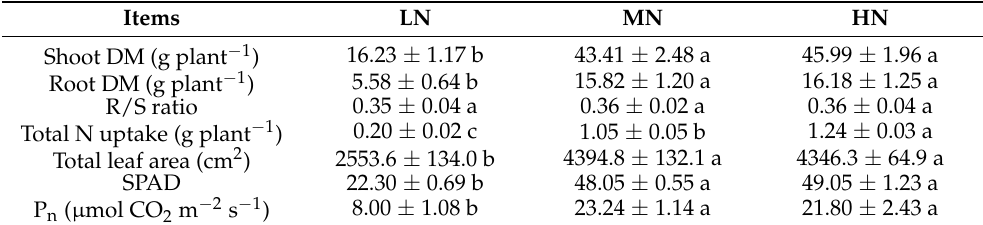
Table 1. Effects of nitrogen (N) availability on maize shoot and root dry matter (DM), N uptake, leaf SPAD readings, leaf area, and photosynthesis (P n ) at 62 days after sowing (DAS) 1 . Items LN MN HN Shoot DM (g plant − 1 )